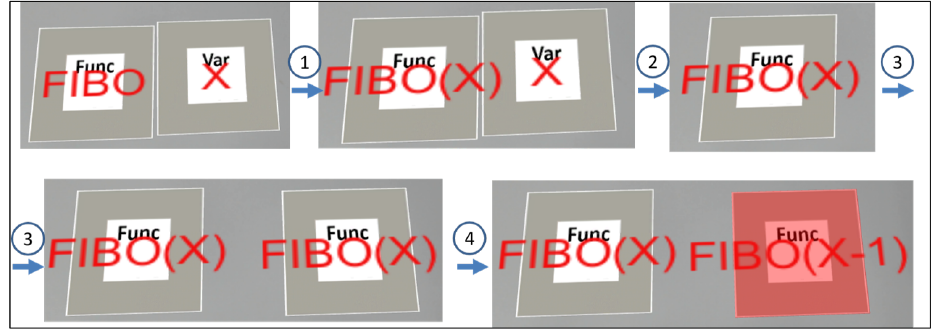
Figure 6. An example to illustrate how to combine the content of multiple markers, operate markers, and modify the marker parameter. First, the user creates function and variable virtual markers. In step 1, the user uses a defining gesture to combine the contents of the two virtual markers into the first virtual marker. In step 2, the user selects a variable virtual marker and uses a deleting gesture to delete the variable virtual marker. In step 3, the user selects the virtual marker and uses the copy gesture to copy it. After completing the copy, the user places the two virtual markers in different positions through dragging gesture. In step 4, the user selects the virtual markers by selecting gesture and uses the parameter/value change gesture to modify the parameter of the selected